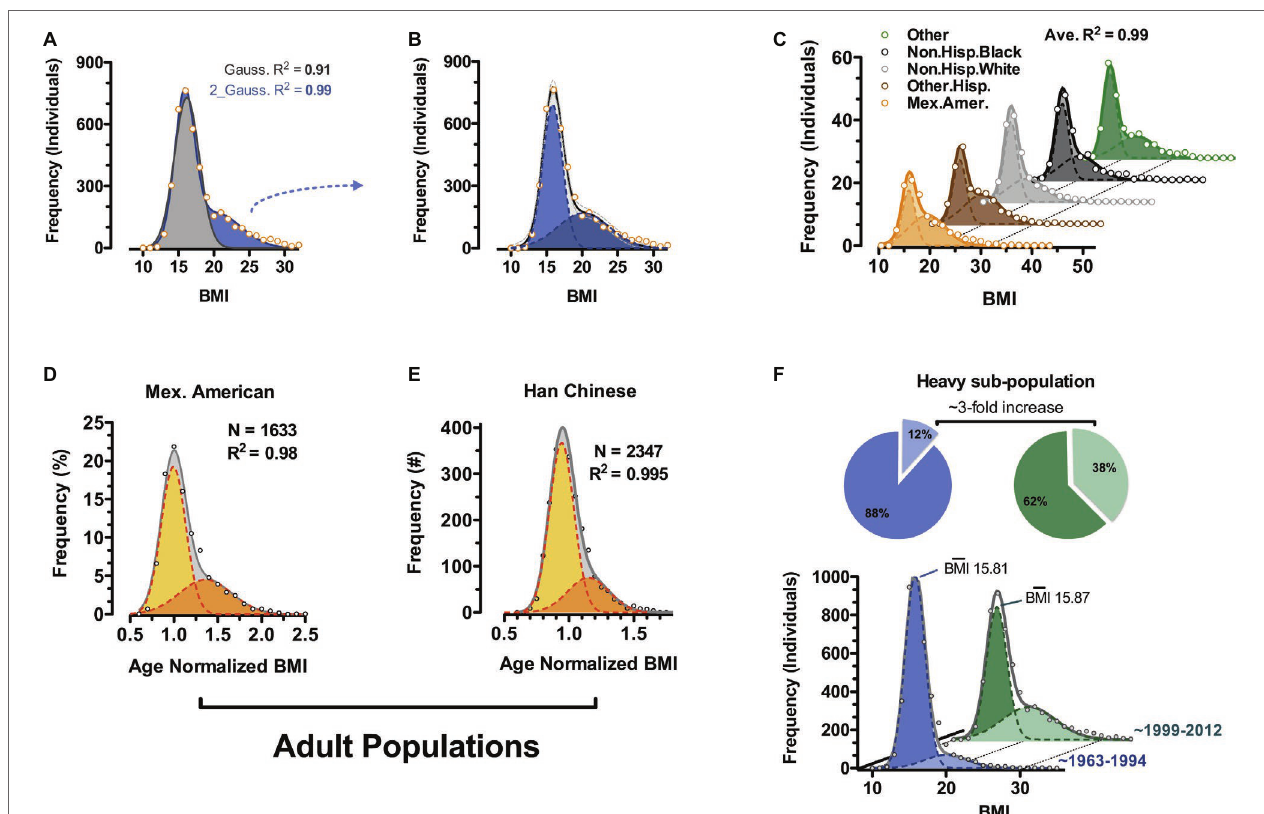
FIGURE 4 | Body mass index bimodality in human. (A) BMI distribution of 6- to 11-year-old non-Hispanic white males from the continuous NHANES 1999–2012 survey (CDC and NCHS, 2012). Data are fit to a single Gaussian (gray) and a double Gaussian (blue). (B) Individual Gaussian components of the double Gaussian from (A) . (C) Near-perfect double-Gaussian fit is observed across children of five major ethnicity classes, as well as in adult cohorts from (D) continuous NHANES 1999–2012 (CDC and NCHS, 2012) and (E) Han Chinese populations. (D,E) Shown are age-normalized BMI distributions for females aged 25–50. (F) Comparison of similar fitting of childhood data from continuous NHANES 1999–2012 (CDC and NCHS, 2012) and prior NHANES/NHES surveys (1963–1994) (CDC and NCHS, 1994) shows a marked shift in recent decades where the heavy sub-population triples in size (pie charts). (Reproduced with permission from Dalgaard et al.,